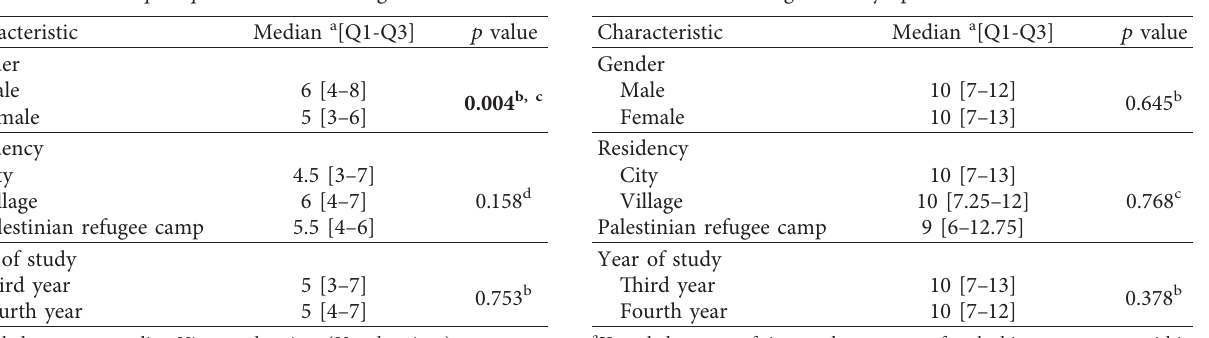
Table 10: Association between nursing students’ demographic characteristics and signs and symptoms